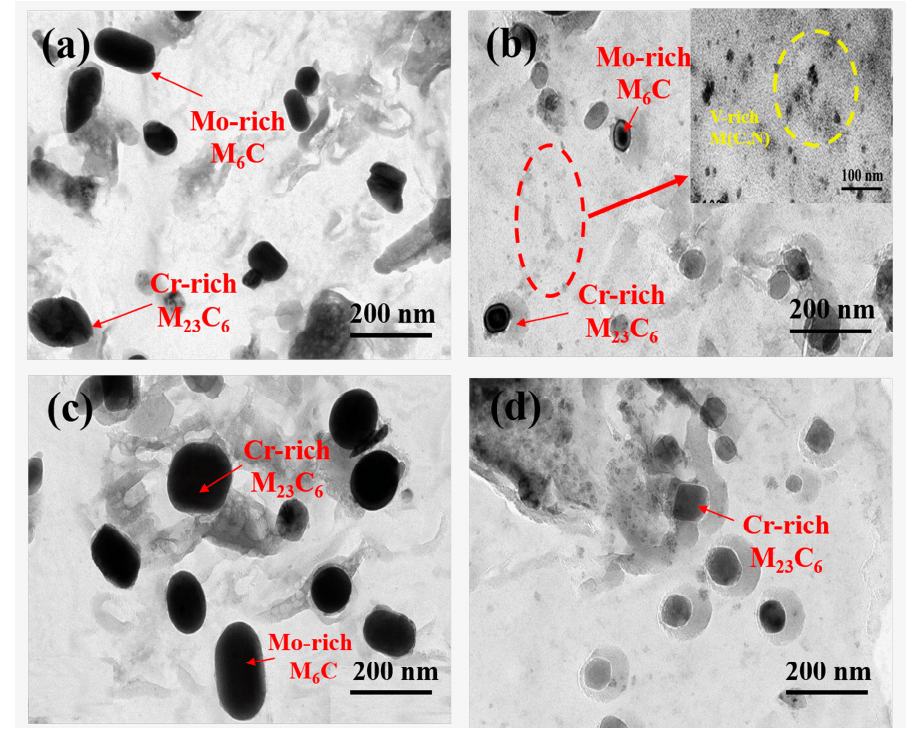
Figure 5. Bright-field transmission electron microscopy (TEM) micrographs of precipitates extracted from the specimen tempered at different temperature for 4 h: ( a ) Nitrogen-free steel (600 °C); ( b ) nitrogen-alloyed steel (600 °C); ( c ) nitrogen-free steel (650 °C); ( d ) nitrogen-alloyed steel (650 °C).